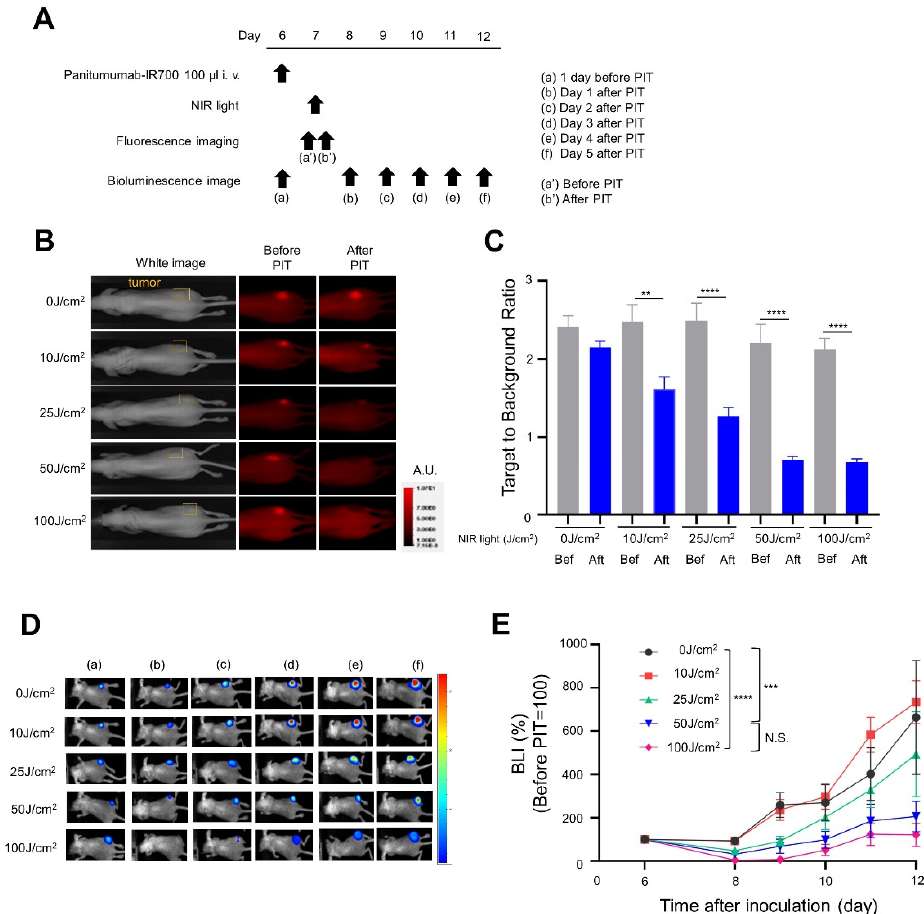
Figure 2. In vivo short-term efficacy of NIR-PIT with Pan-IR700 in A431-GFP-luc cells: ( A ) NIR-PIT regimen—bioluminescence and fluorescence images were obtained at each time point indicated; ( B ) fluorescence images for IR700 fluorescence—the yellow areas represent the location of the